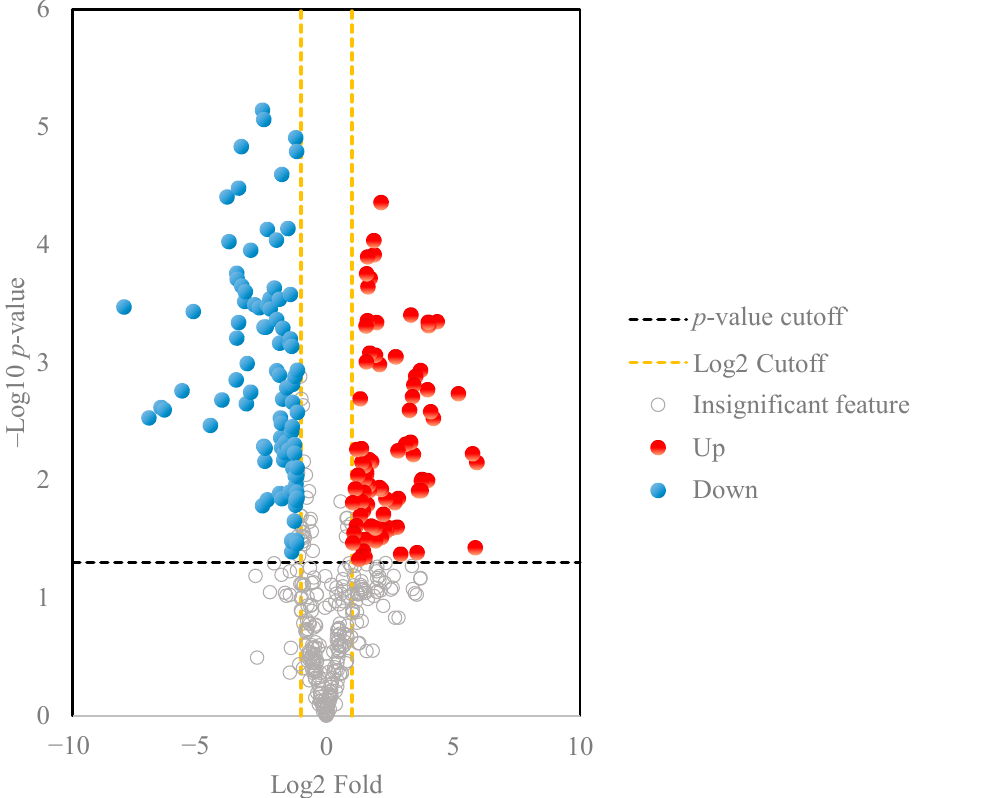
Figure 3. Volcano plots results of ginsenoside features in the ginseng samples. The order of the metabolites on the y-axis is determined by the statistical significance p -value of the ratio fold- change.